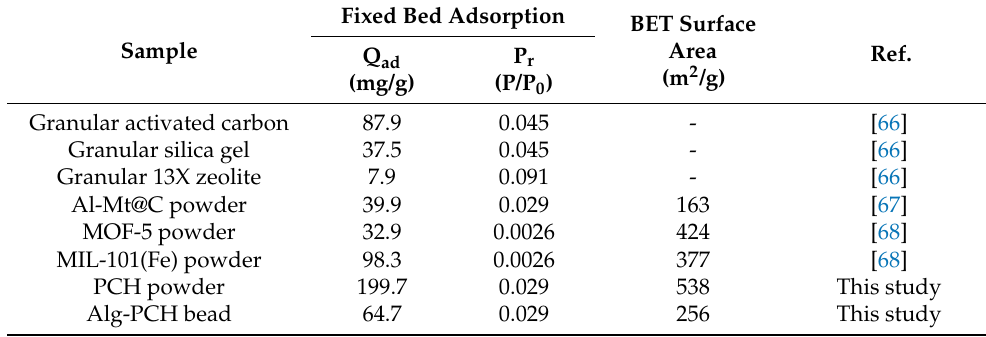
Table 4. Summarized toluene adsorption capacities and BET surface area of various